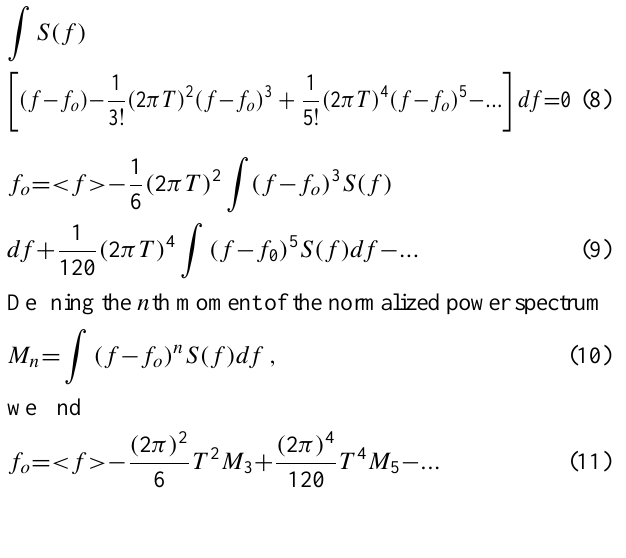
multi pulse experiment (after Fig. 5b in Uspensky et al., 2004 1 ).